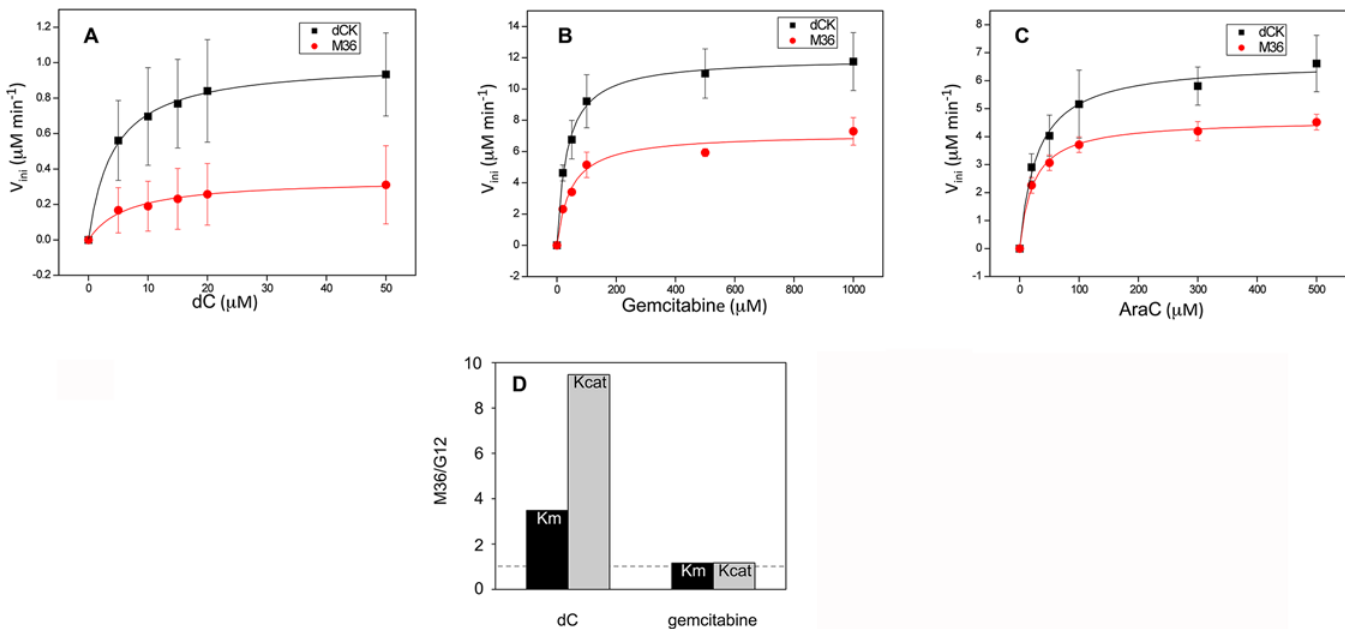
Fig 8. Biochemical comparative characterisation of phosphorylation of AraC by wt dCK and M36. Panels A and C. Phosphorylation kinetics of purified wt dCK (black squares) and M36 (red circles). Steady state kinetic data were fitted according to the Michaelis-Menten equation. Panel A, phosphorylation of dC (average of four independent experiments). Panel B, phosphorylation of gemcitabine (average of four independent experiments). Panel C, phosphorylation of AraC (average of three independent experiments). Panel D, ratio of Km (black) and of Kcat (grey) for M36 vs G12, with respect to dC and to gemcitabine. The dotted line gives the reference of a ratio of 1.